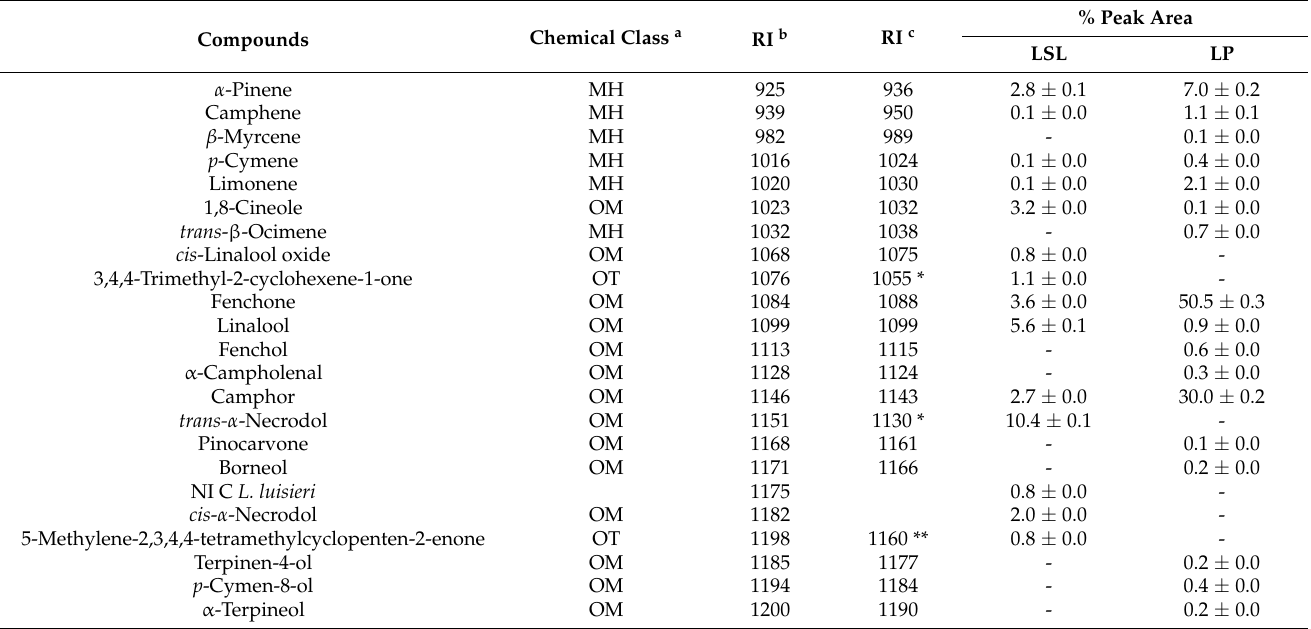
Table 2. Identification and relative amounts of compounds of L. stoechas subsp. luisieri (LSL) and L. pedunculata (LP) essential